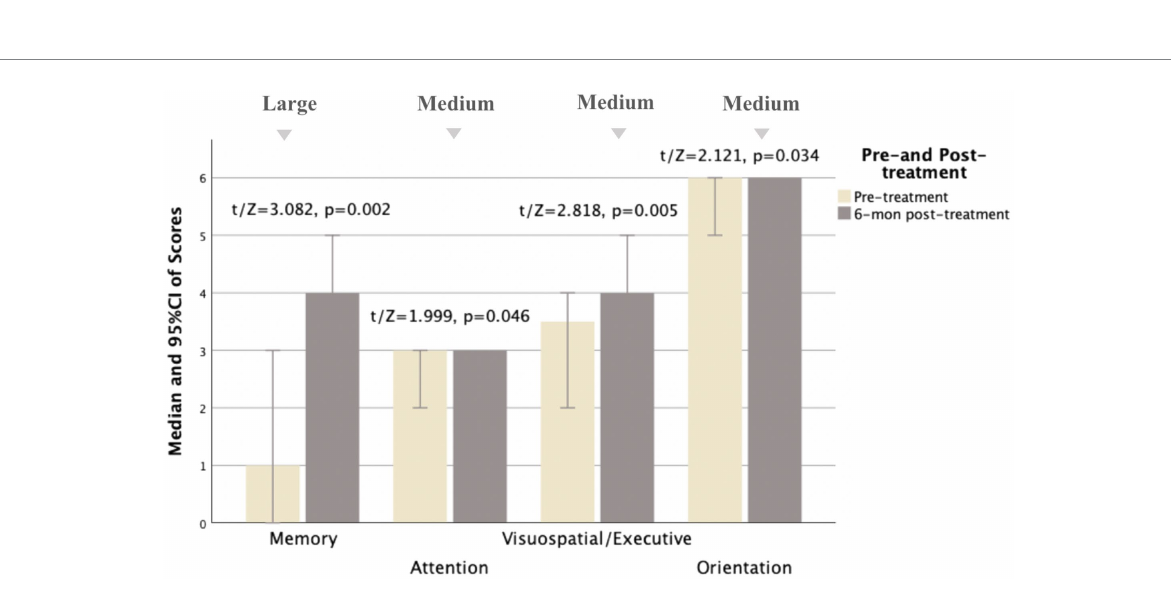
Table 7. But baseline age, education, duration of disease, and